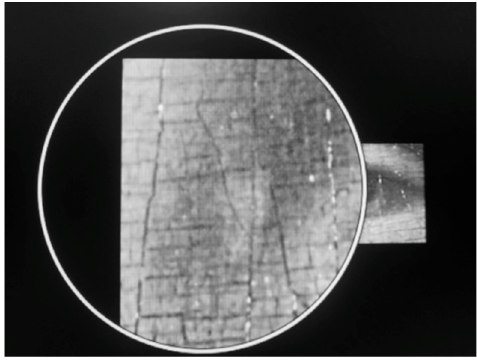
Figure 5. Mona Lisa’s beauty spot under the magnifying glass.